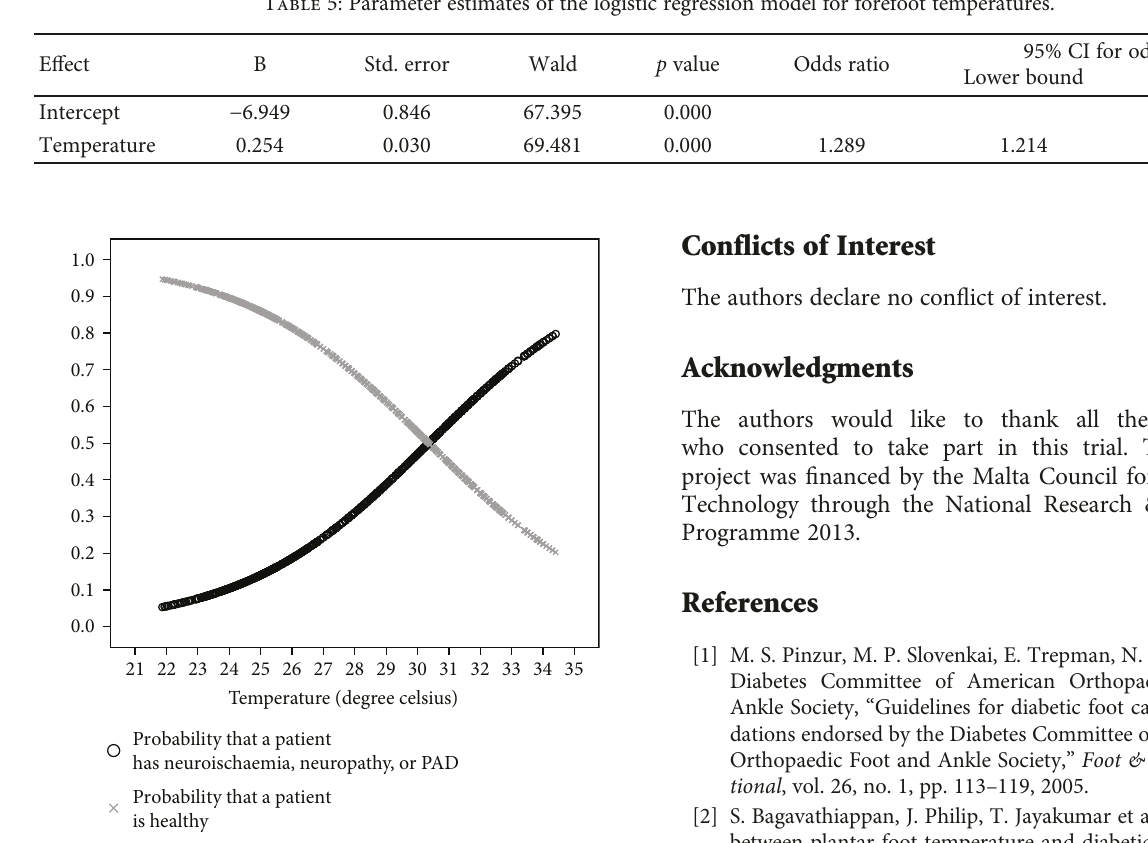
Table 5: Parameter estimates of the logistic regression model for forefoot temperatures.